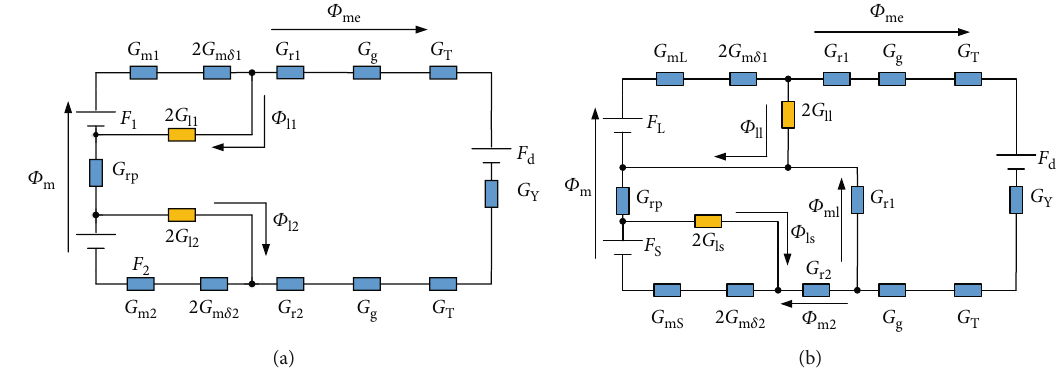
Figure 3: The equivalent magnetic circuit models: (a) traditional V-type; (b) asymmetrical magnetic poles.